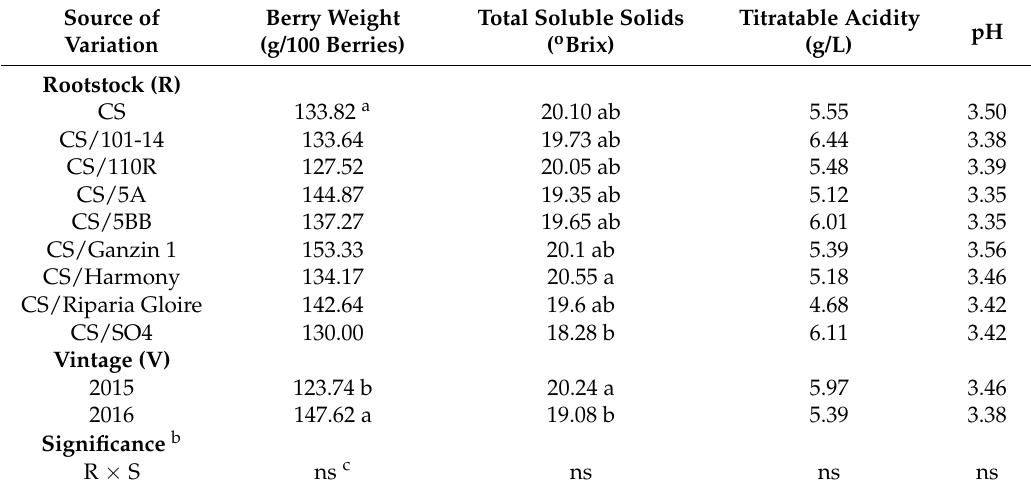
Table 2. Effects of rootstocks on physiochemical parameters of mature berries in two seasons